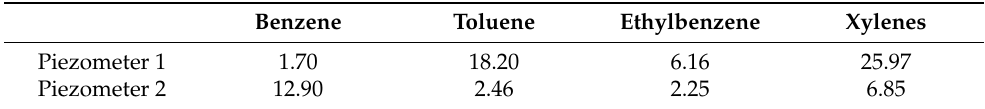
Table 1. BTEX (E stands for ethylbenzene) concentrations (ppm) of groundwater sampled in Piezome- ter 1 and Piezometer 2 measured by